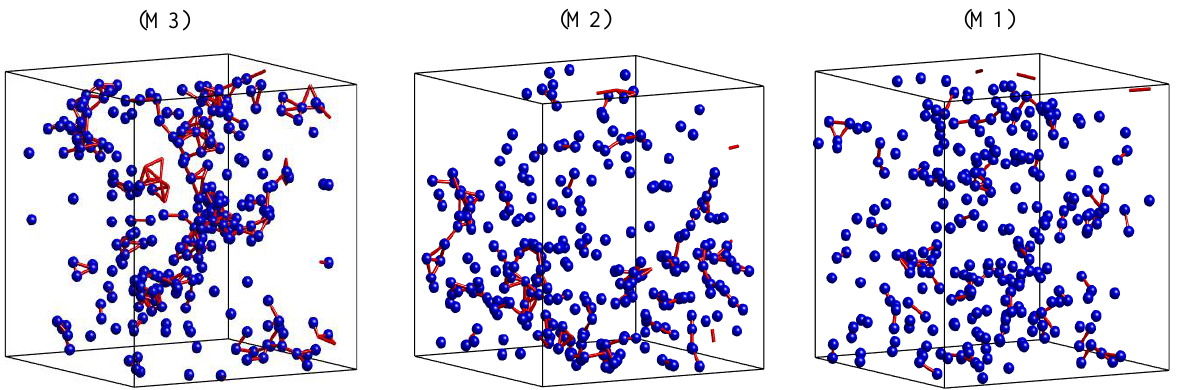
Figure 6. Snapshot of the positions of 5 % the most mobile (M3), 5 % the most immobile (M2) atoms and 5 % the randomly atoms (M1) in SiO 2 liquid. Here the blue sphere is Si or O